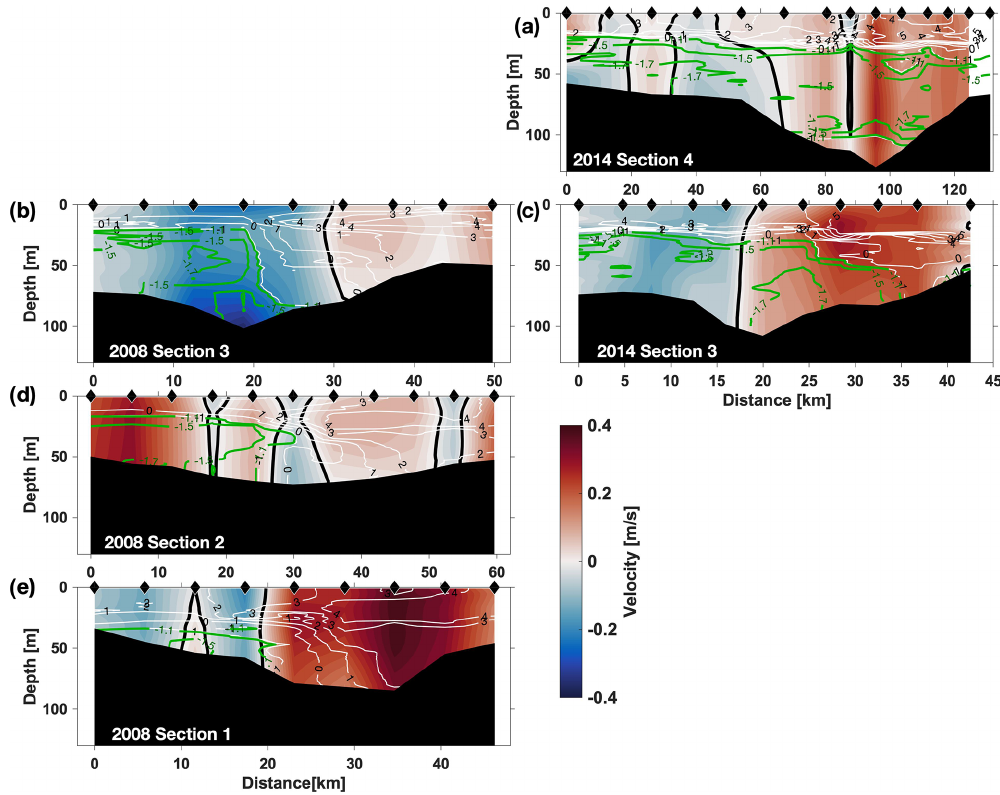
Figure 5. Cross-section velocities in 2008 for sections from north (b, d, e) and in 2014 (a, c) . Shown in all panels is geostrophic shear referenced to the cross-section component of de-tided surface velocities from ship’s drift (2008) and LADCP (2014). The white contours show temperature from − 1 to 8 ◦ C at 1 ◦ C intervals; the green ones show temperature from − 1 . 3 to − 1 . 7 ◦ C at 0.2 ◦ C to highlight the temperature structure within the WW. Please note that all sections cover different horizontal distances.